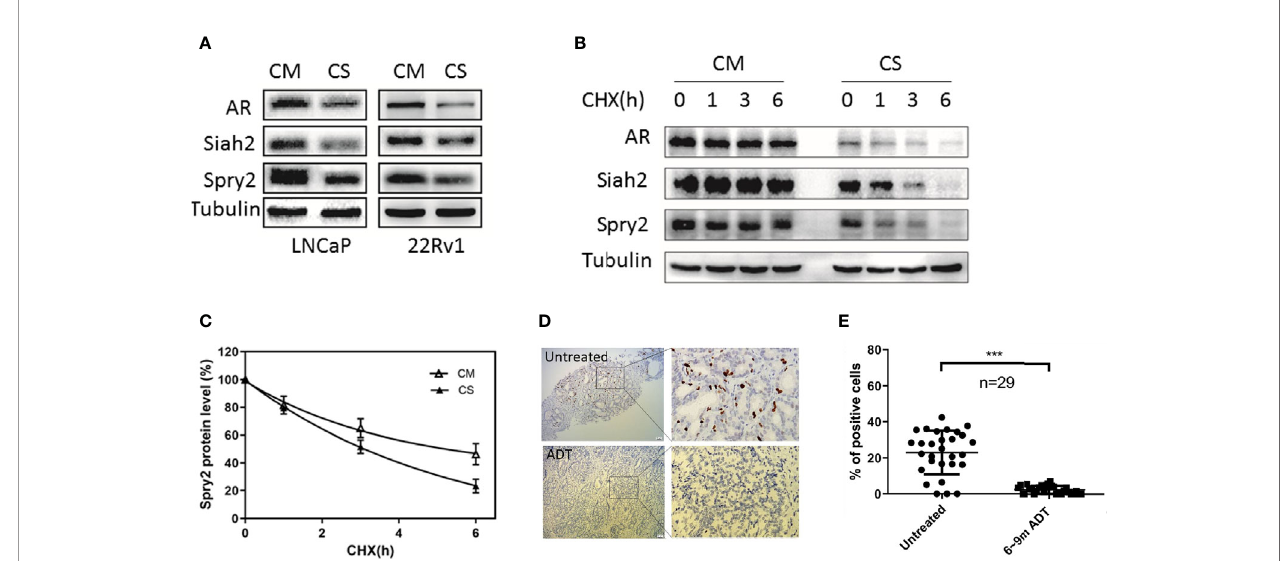
FIGURE 3 | ADT decreased Siah2 expression and increased its ligase activity. (A) LNCaP and 22Rv1 cells were cultured in complete medium for 24 h, and then maintained in CS-FBS medium for another 24 h. Spry2, Siah2, and AR protein expression were detected by Western blotting. (B) LNCaP cells were treated as described in (A) , and then treated with cycloheximide (CHX, 50 m g/ml) for 1, 3, and 6 h, after which cell lysates were subjected to Western blotting. (C) Degradation curves of Siah2 by cycloheximide chase experiments. (D) Representative images of Siah2 immunohistochemistry staining in PCa specimens from the same patient. (E) Quanti fi cation of Siah2 immunohistochemistry staining in PCa samples from 29 patients who underwent radical prostatectomy after between 6 and 9 months of ADT treatment. ***P <